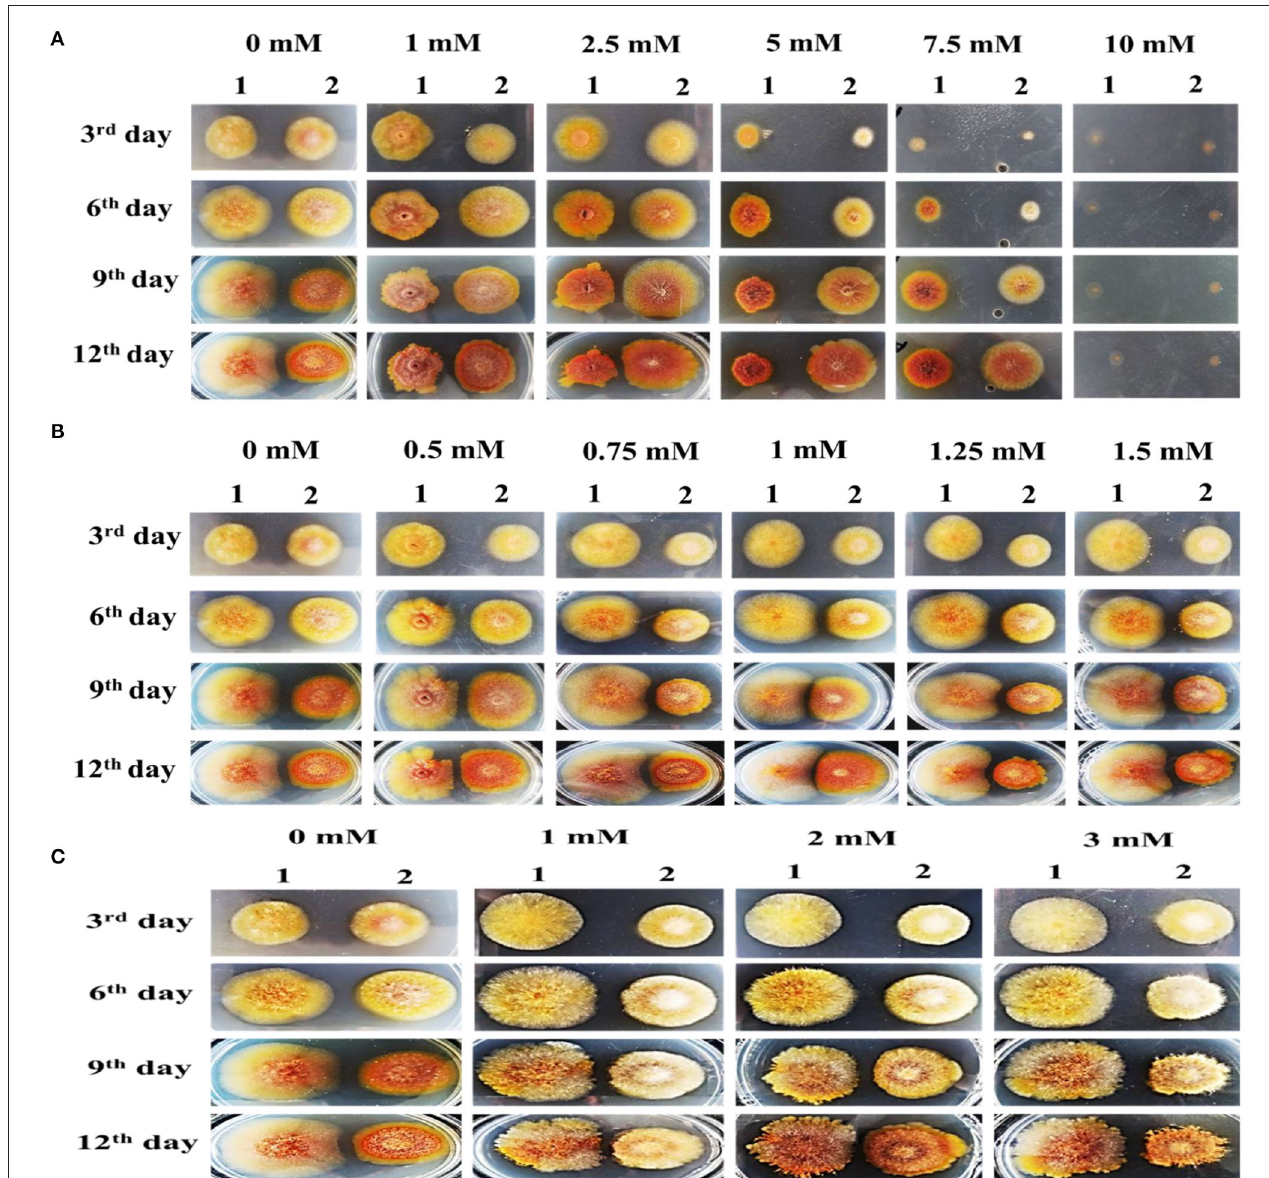
FIGURE 13 | Colony morphology of M. ruber M7 and 1 abct 31 for the feeding of weak acids. The morphologies of M. ruber M7 (1st vertical row) and 1 abct 31 (2nd vertical row) colonies on PDA plates supplemented with weak acid at 28 ◦ C for 12d. (A) Colony morphology of M. ruber M7 and 1 abct 31 for the feeding of sorbic acids at 0, 1, 2.5, 5, 7.5, and 10mM concentration, respectively; (B) Colony morphology of M. ruber M7 and 1 abct 31 for the feeding of acetic acids at 0, 0.5, 0.75, 1, 1.25, 1.5mM concentration, respectively; (C) Colony morphology of M. ruber M7 and 1 abct 31 for the feeding of adipic acids at 0, 1, 2, and 3mM concentration,